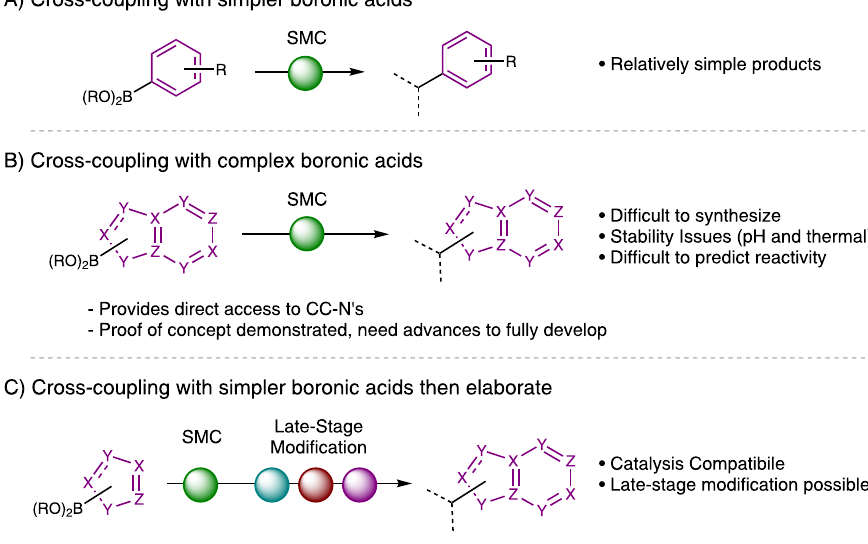
Fig. 3 Synthetic strategies toward CC-Ns. A Cross-coupling with simpler boronic acids leads to simple CC-Ns. B Cross-coupling with complex boronic acids. C Cross-coupling with simpler boronic acids then elaborate to complex